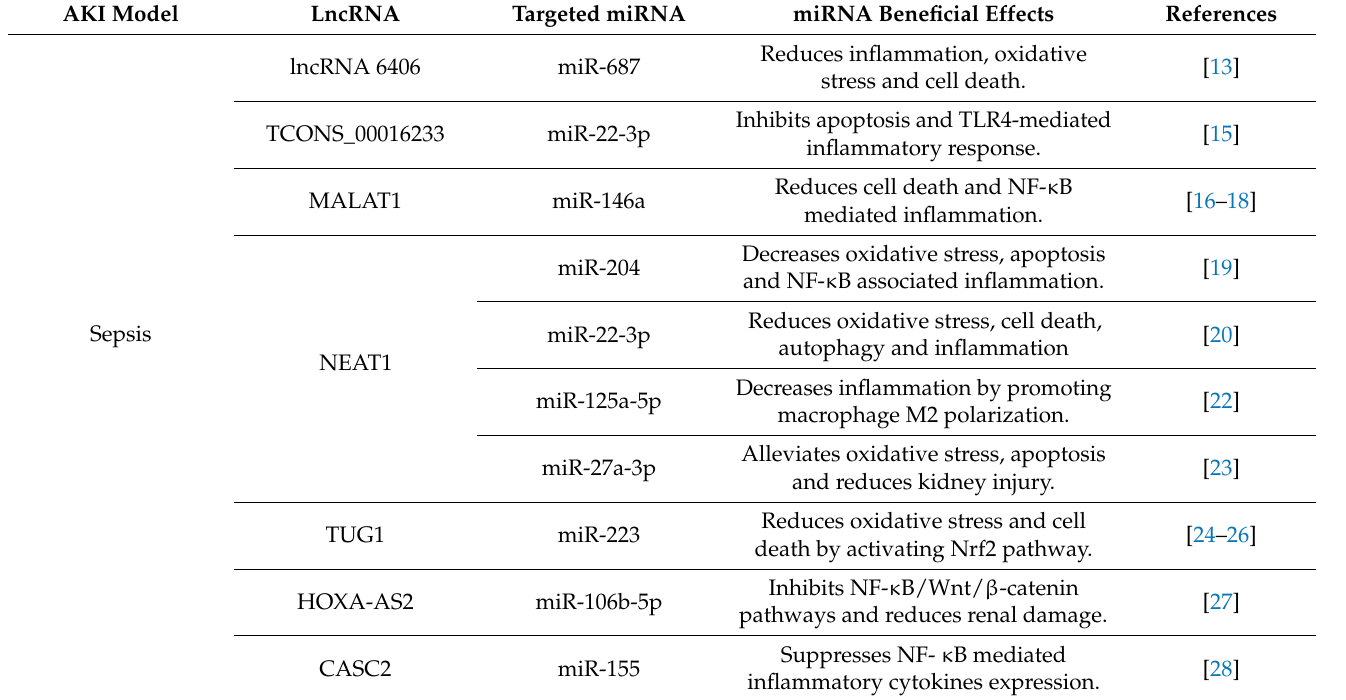
Table 1. Effects of LncRNAs in experimental